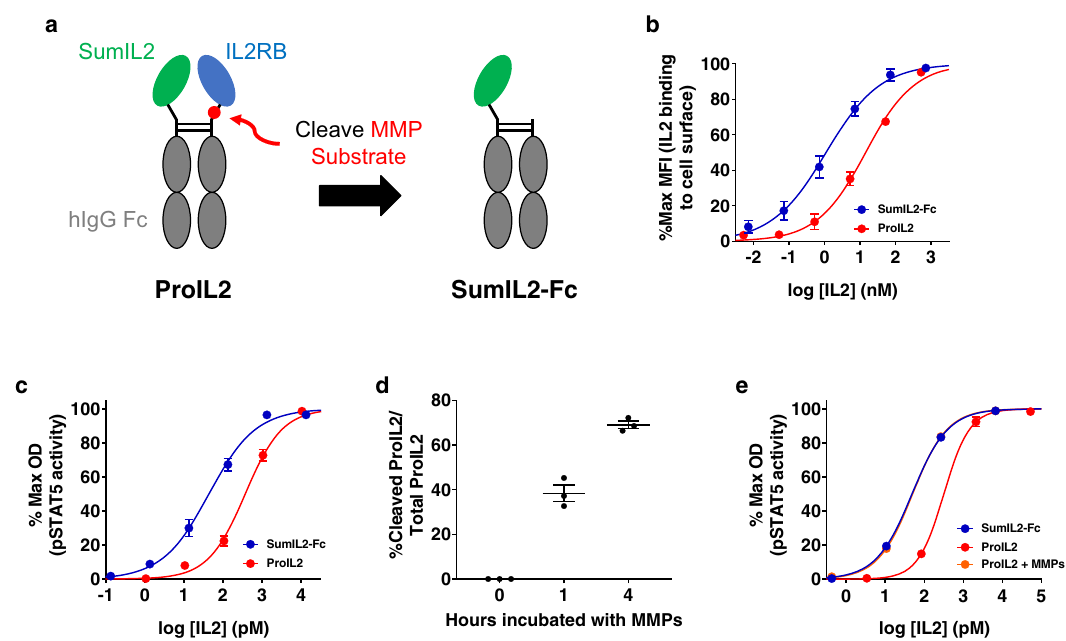
Fig. 2 ProIL2 effectively masks IL-2 activity and is cleaved by MMPs in vitro. a Schematic of ProIL2 depicting that IL-2 receptor beta (IL2RB) binds and blocks IL-2 activity prior to cleavage (left) and activates into SumIL2-Fc upon MMP cleavage (right). b Binding of SumIL2-Fc and ProIL2 at different doses to HEK-Blue TM IL-2 reporter cells was assessed via fl ow cytometry ( n = 3 experiments, total 3 replicates per group). c Functional activity of SumIL2-Fc and ProIL2 was assessed by using HEK-Blue TM IL-2 reporter cell assay ( n = 3 experiments, total 9 replicates per group). d Protease activation of ProIL2. ProIL2 was incubated with human MMP2, MMP9, and MMP14 for 1 or 4 h, then run on non-reducing SDS-PAGE, where gel band intensity was subsequently quanti fi ed ( n = 3 experiments). e Functional activity of SumIL2-Fc, ProIL2, and ProIL2 that was incubated with human MMP2, MMP9, and MMP14 for 4 h was assessed by using HEK-BlueTM IL-2 reporter cell assay ( n = 1 representative experiment of 2 experiments, 3 replicates each group per experiment, total 6 replicates). Data represent mean ± s.e.m. Source data are provided as a Source Data fi